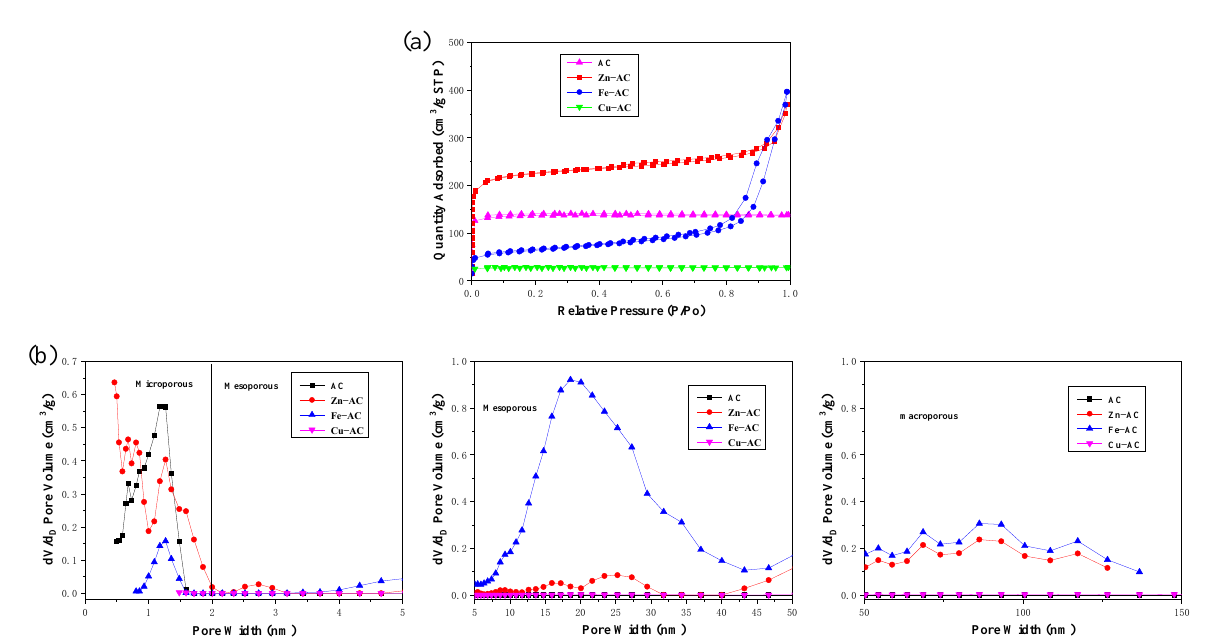
Figure 3. ( a ) The N 2 adsorption/desorption isotherms and ( b ) pore size distribution for the sam- ples.